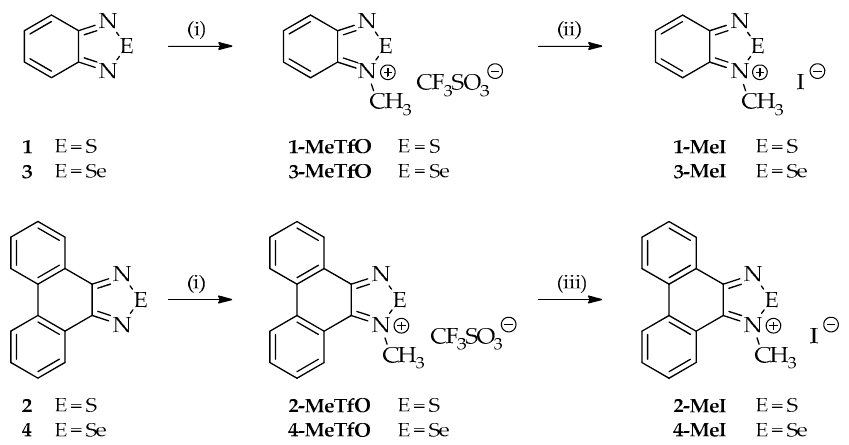
Figure 4. Syntheses of all compounds: ( i ) CF 3 SO 3 CH 3 , dry (CH 2 Cl) 2 , 60 °C; ( ii ) Bu 4 NBr, MeOH/toluene; and ( iii ) NaI, acetone.